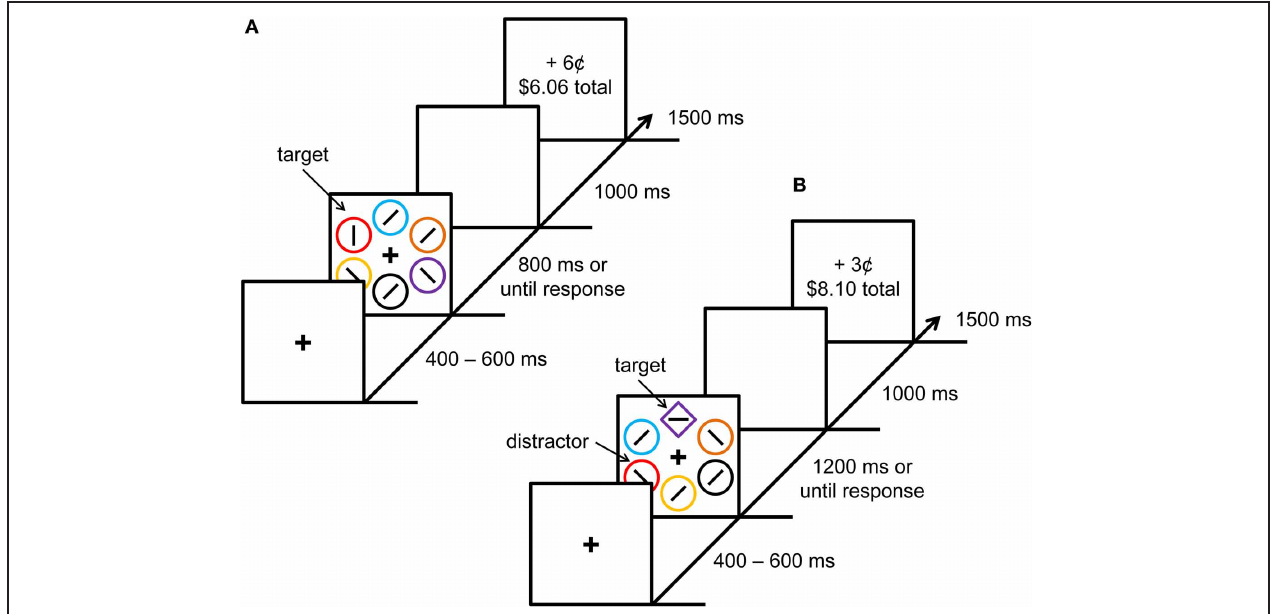
FIGURE 1 | Experimental paradigm. Sequence of events and time course for a trial during the training phase (A) and test phase (B) . Each trial was followed by a blank 1000ms intertrial